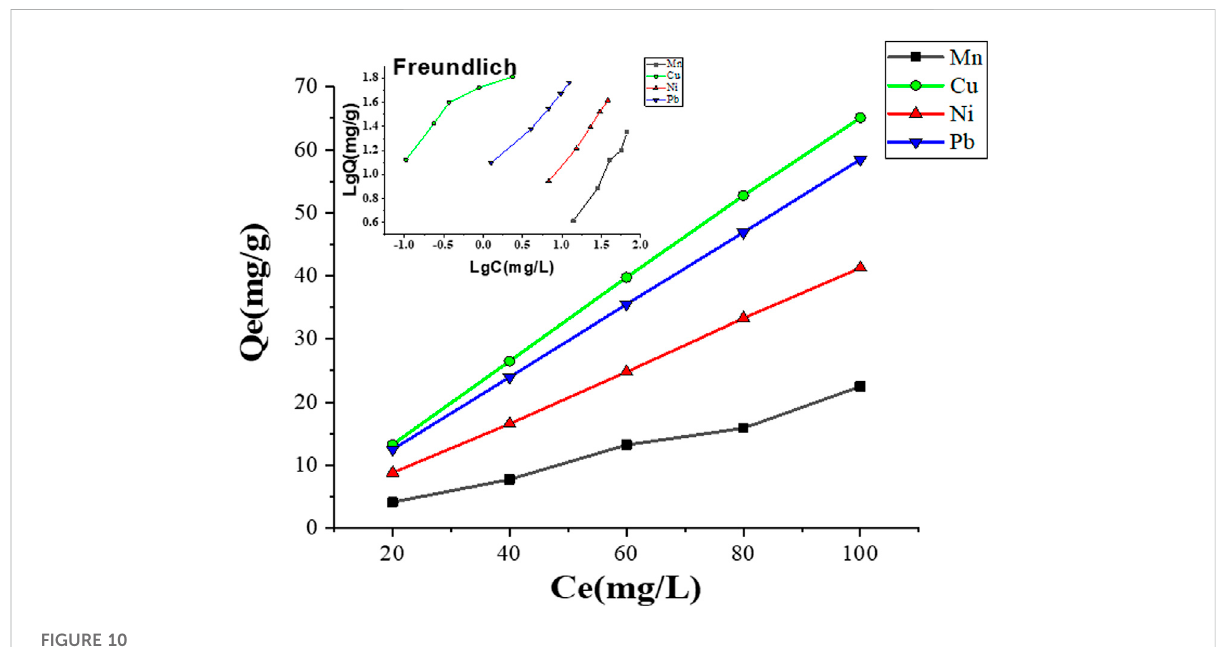
FIGURE 10 Isotherm curves for MCFA adsorption of HMs.